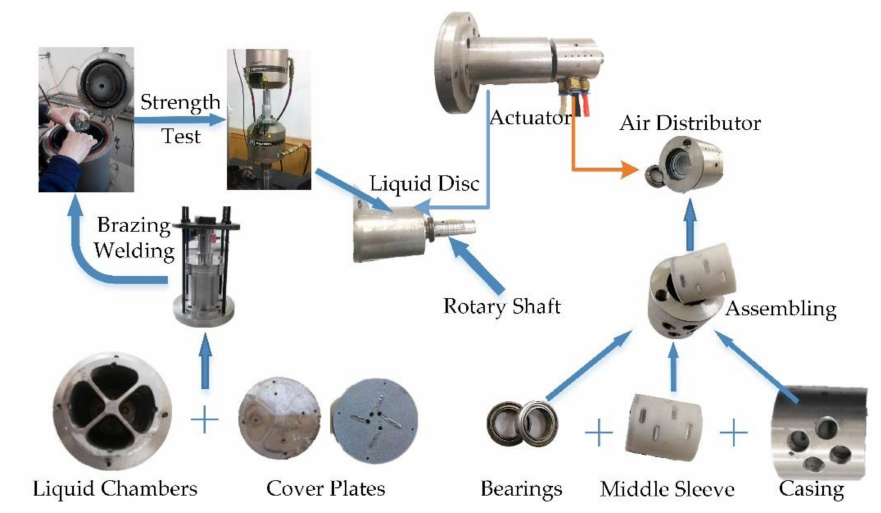
Figure 2. Structure of the balance